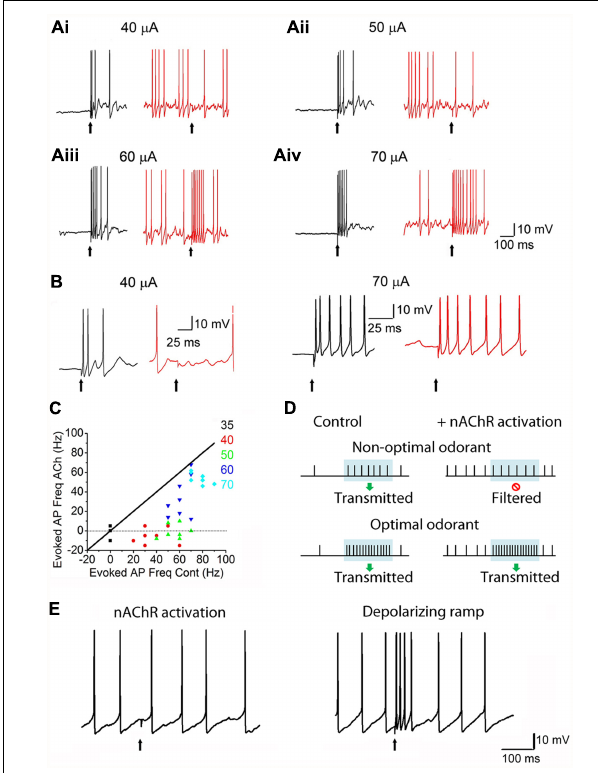
FIGURE 4 | nAChRs act as high-pass filters of glomerular output. (Ai) : Responses of MCs to ON stimulation, recorded under current-clamp. Left: (A) 40 μ A ON stimulus causes an MC to exhibit a burst of spikes. Right: during a ACh/At-mediated depolarization (and enhanced background firing), the 40 μ A stimulus fails to evoke a response in the same MC. ACh/At refers to a 1 s focal application of 1 mM ACh in the presence of 2 μ M atropine, the latter also added in the bath in order to block mAChRs. (Aii–iv) : Similar data for 50, 60, and 70 μ A stimuli, respectively.While the 50 μ A stimulus also fails to evoke a response during the ACh/At-mediated spiking in the same MC as in Ai, the MC responds to higher stimuli with increased spiking. In all cases, control traces are in black and traces in the presence of ACh/At are in red. (B) : Expanded traces from Ai and Aiv. (C) : Scatter plot of net increase in spiking upon ON stimulation, during the ACh/At-mediated depolarization, plotted against the same during control conditions. Data is from the same cell as in (A,B) . Net increase in spiking was calculated by subtracting the mean firing frequency before ON stimulation from the mean firing frequency during the 100 ms window after ON stimulation.While responses to all stimulus intensities were suppressed during the ACh-mediated depolarization, lower intensity stimuli (up to 50 μ A) show a filtering of MC responses (not different from 0). Diagonal line (slope = 1) is where the points would lie if there were no ACh-mediated filtering. (D) : Cartoon summarizing the effects of nAChRs on MC responses. Period of odor exposure shown by shaded box. Under non-optimal conditions (weak odor), a MC fires a burst of APs during odor exposure leading to signal transmission. On the other hand, nAChR activation, causes an increase in basal MC firing but shows no net change in firing patterns during the period of odor exposure thus resulting in filtering of the response. Under optimal conditions (i.e., strong odor), there is a net increase in MC firing during odor exposure both under control conditions and when nAChRs are activated. (E) : Filtering shown in the presence of ACh/At (left trace) is not seen when the same cell is depolarized via current injection to elicit APs in the absence of ACh/At (right trace, from the same cell).This suggests that optimal excitation-driven feedback inhibition requires the activation of more than one MC, and that the filtering is not merely a result of MC membrane depolarization. Figures (A–C,E) adapted, with permission, from D’Souza andVijayaraghavan (2012).